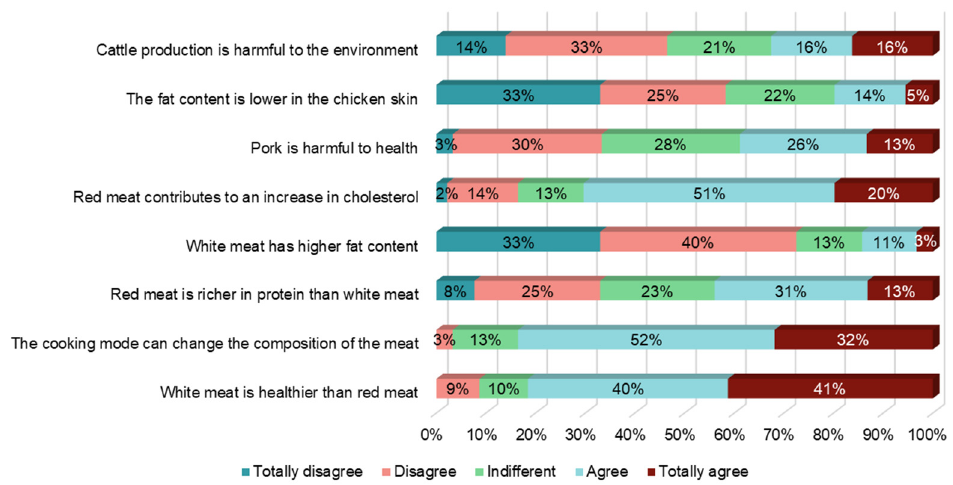
Figure 1. Level of agreement of the participants with different statements related to meat.